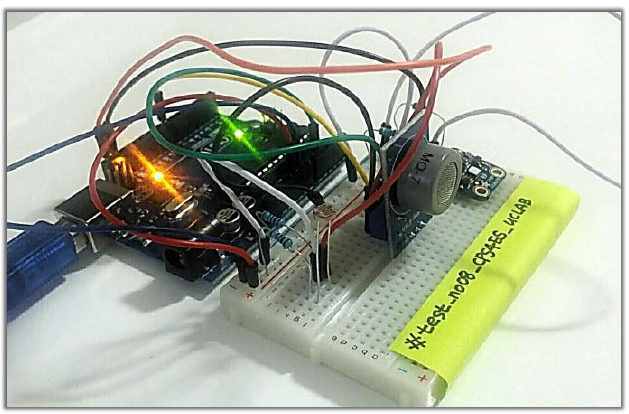
Figure 13. The Arduino used in the system